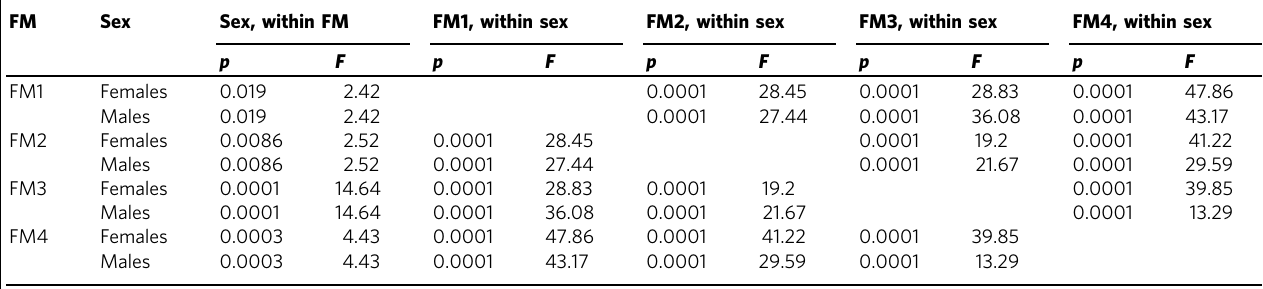
Table showing p and F values associated with sex-associated differences in richness within each FM, and FM-associated differences in richness within each